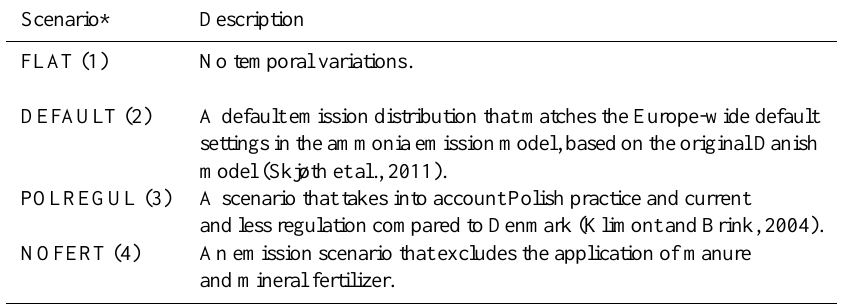
Table 2. The emission scenarios used in this study. Scenario* Description FLAT (1) No temporal variations. DEFAULT (2) A default emission distribution that matches the Europe-wide default settings in the ammonia emission model, based on the original Danish model (Skjøth et al., 2011). POLREGUL (3) A scenario that takes into account Polish practice and current and less regulation compared to Denmark (Klimont and Brink, 2004). NOFERT (4) An emission scenario that excludes the application of manure and mineral